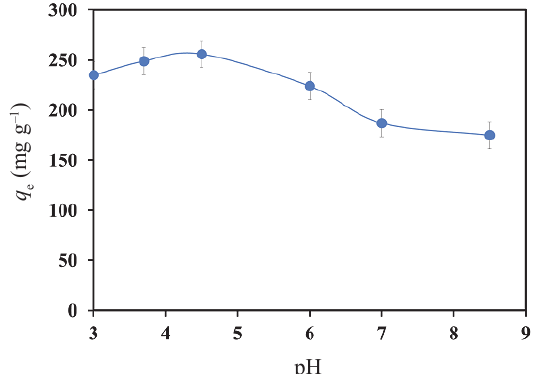
Fig. 8- Fig. 8 – Effect of pH on the sorption of Cr(VI) onto IL-rGO (sorbent dosage = 0.5 g L –1 , [Cr(VI)] = 250 mg L –1 , contact time = 5 h, temperature = 298 K and [Cr(VI)] = 250 mg L –1 )